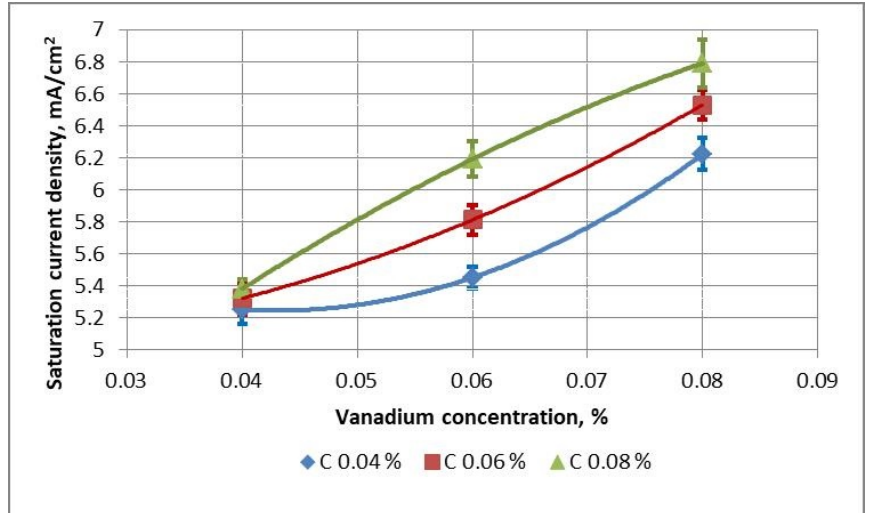
Figure 5. Dependence of the saturation current density on the vanadium content at various carbon content.